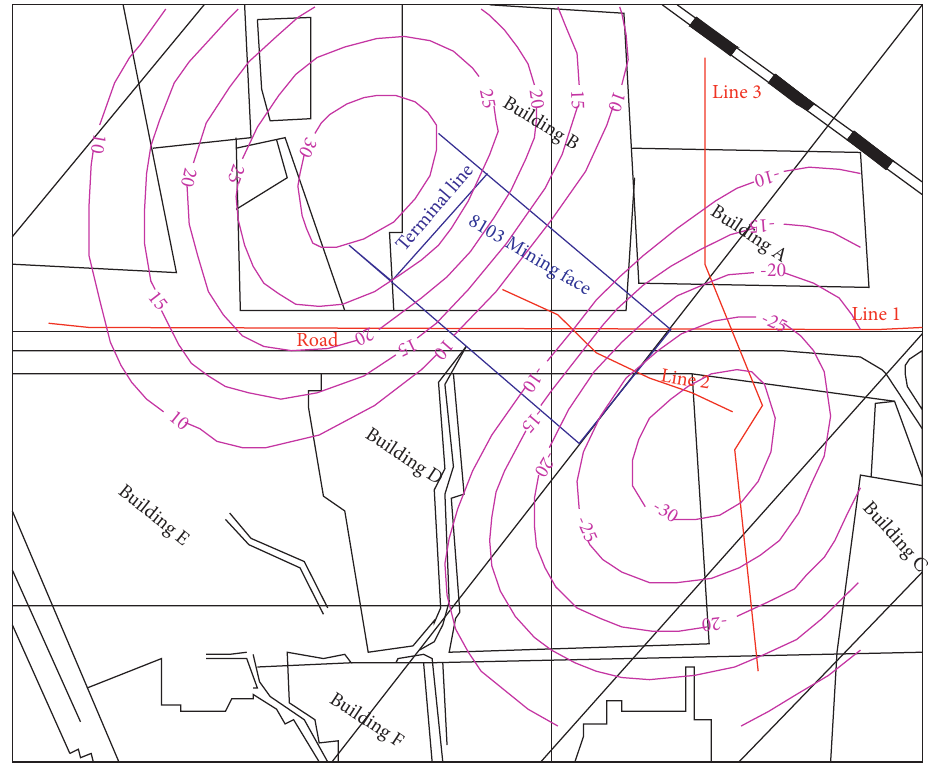
Figure 22: Forecast contour of surface horizontal movement along strike in 8103 backfilling mining.